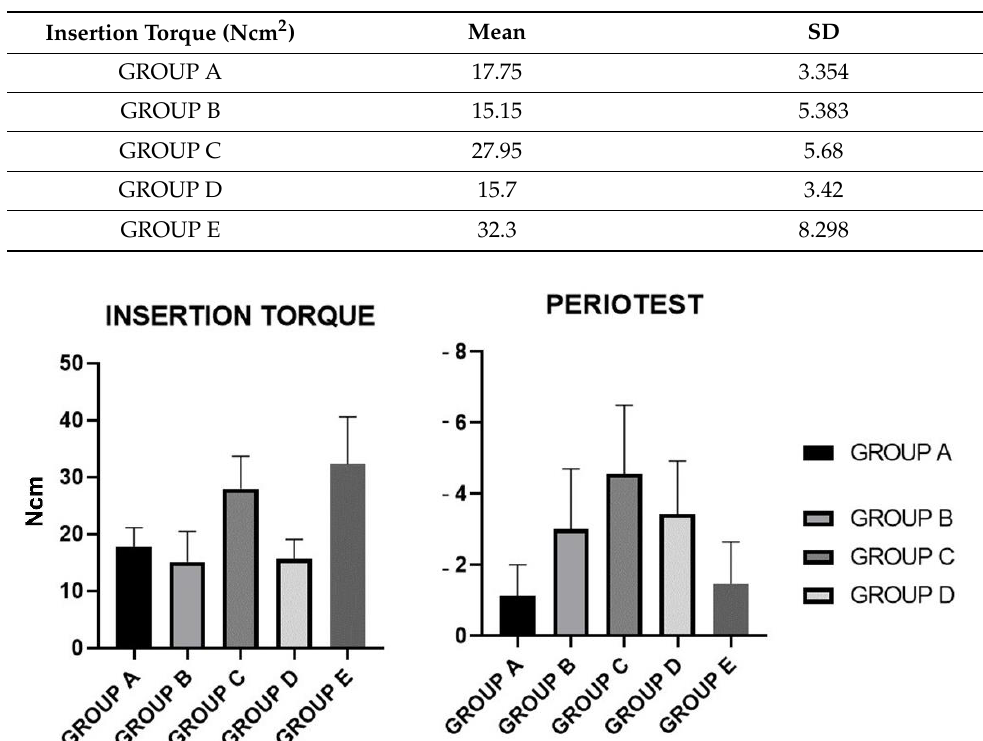
Figure 8. Insertion torque and Periotest means of the study groups.